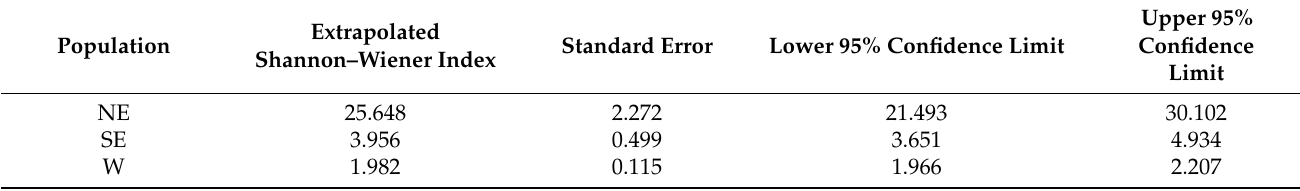
Table 3. Predicted values of the Shannon–Wiener index for haplotype richness of the preserved populations of Mustela lutreola , assuming full sample representativeness (population abbreviations as described in the main